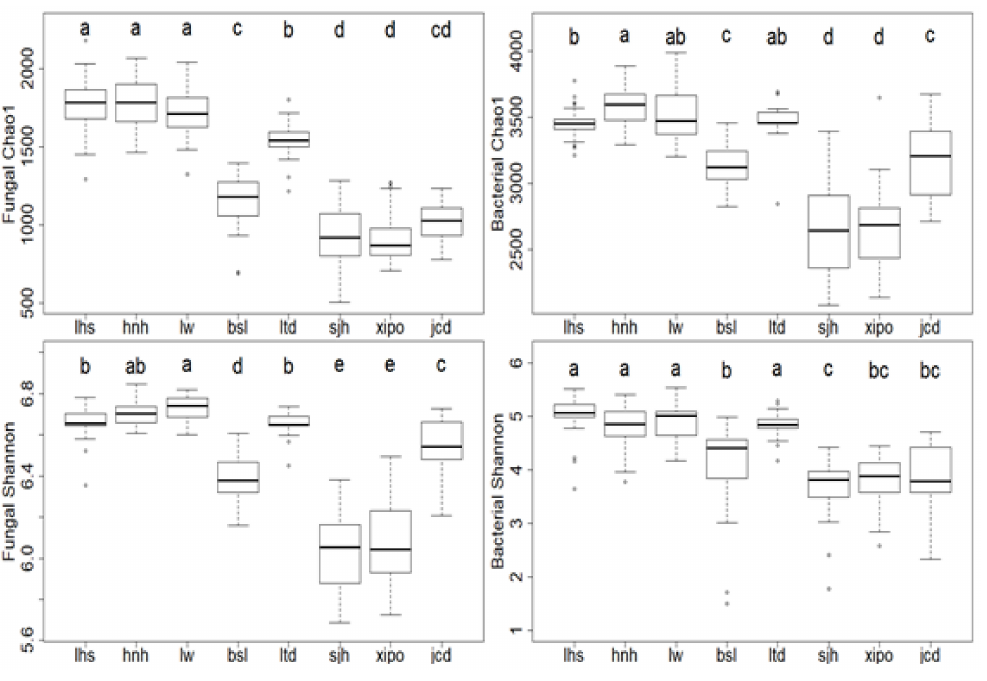
Figure 4. Microbial diversity along the elevation gradient. Different letters (a–e) indicate significant differences among different sampling